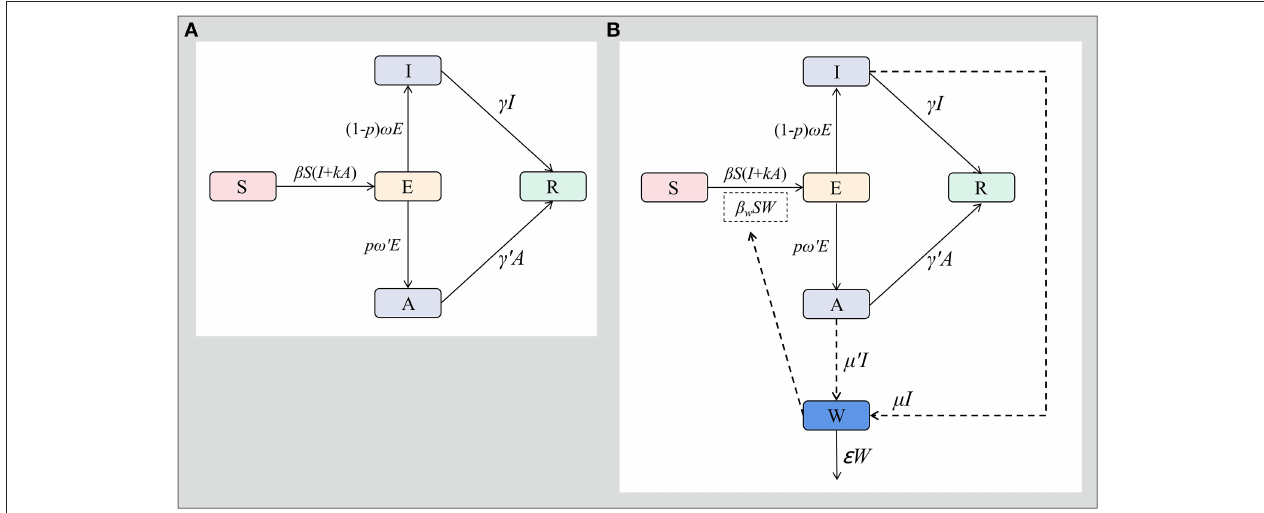
FIGURE 2 | SEIAR model and SEIARW model for norovirus transmission in Jiangsu Province. [ A : susceptible-exposed-symptomatic-asymptomatic-recovered model (SEIAR model), B : susceptible-exposed-symptomatic-asymptomatic-recovered-transmission media model (SEIARW model)]. Both symptomatic and asymptomatic cases contaminate water or food by shedding pathogens into compartment W at shedding rates of µ I and µ ’ A . µ and µ ’ represent shedding